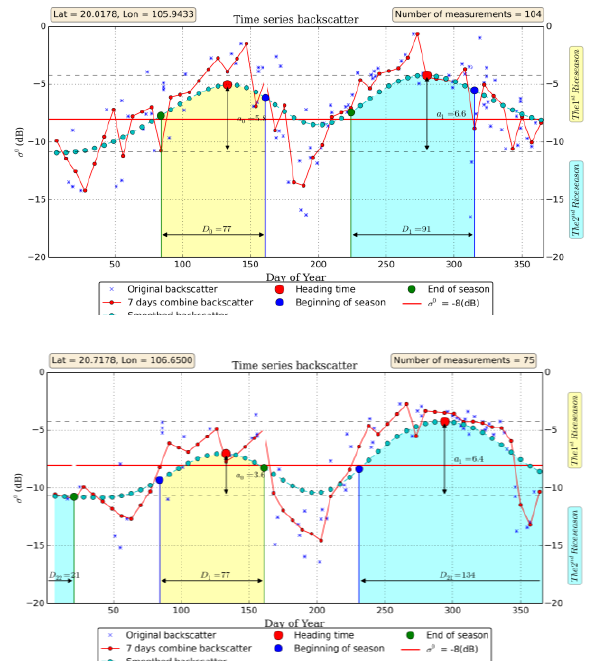
Figure 6. Rice crop phenology parameters retrieval from time series SAR-C band backscatter coefficient (Beginning of rice crop season, End of rice crop season, Heading time, Rice crop amplitude, Length of season)